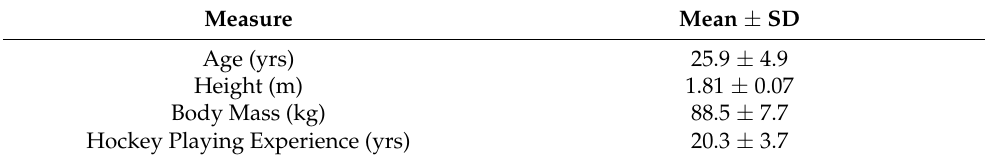
Table 1. Descriptive statistics of study participants.